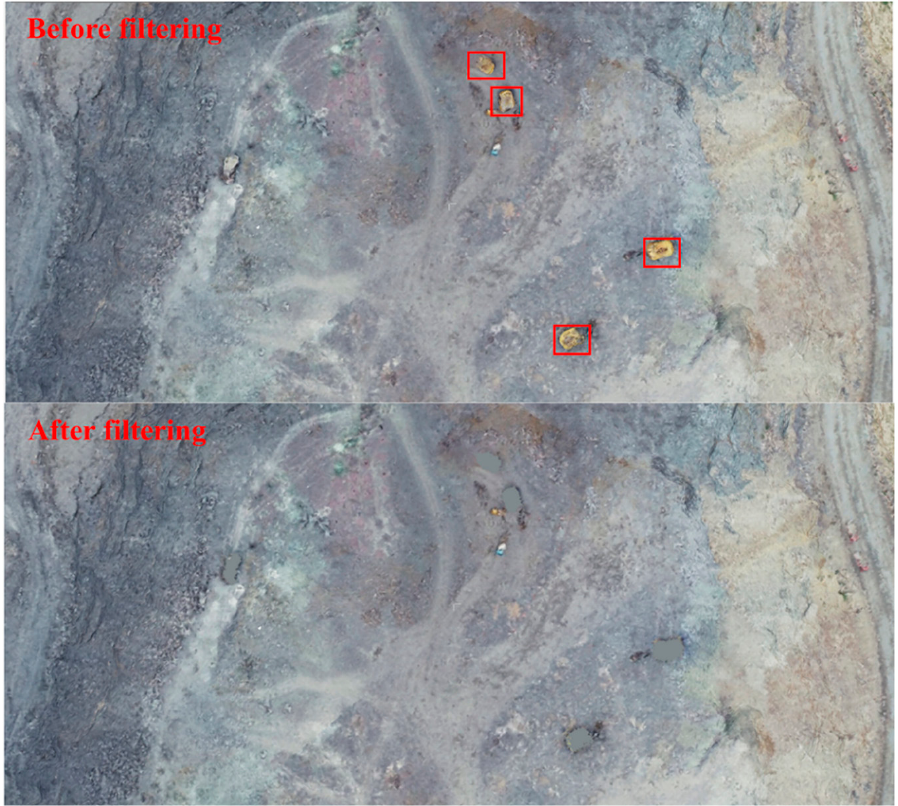
Figure 12. Comparison of results of nonsurface target rejection in the open-pit mine (large-mine-car point clouds in red boxes are filtered out).